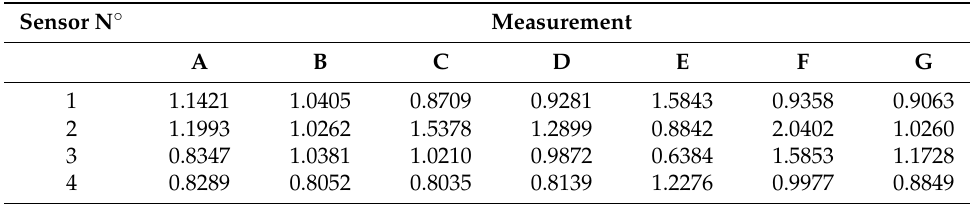
Table 10. Integral of frequency spectrum (10 − 1 ), slab with void below impactor.